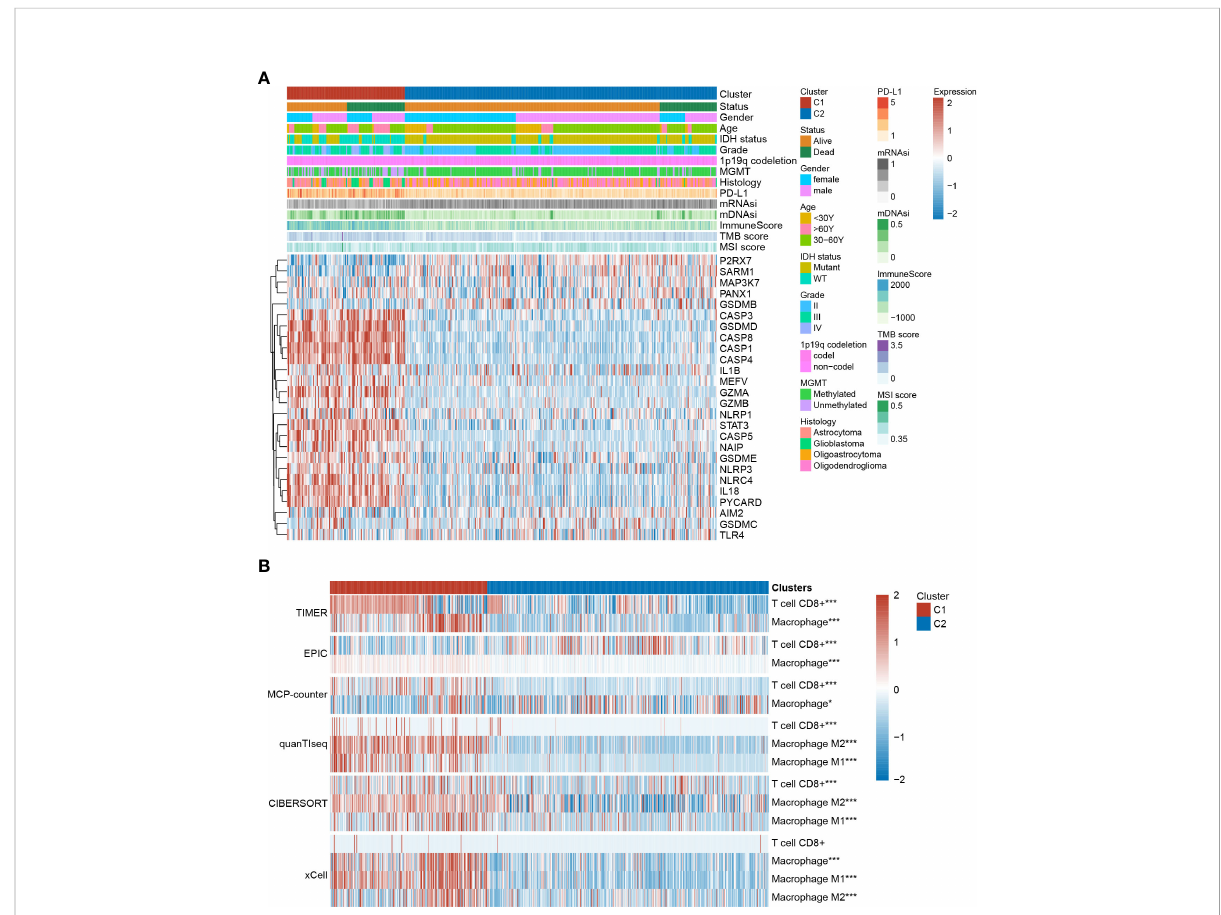
FIGURE 3 The clinical characteristics and immune in fi ltration status differ between Cluster 1 and Cluster 2. (A) Clinical and molecular characteristics of Cluster 1 and Cluster 2. (B) Immune in fi ltration analysis based on TIMER, EPIC, MCP-counter, quanTIseq, CIBERSORT, and xCell algorithms. *P < 0.05; **P < 0.005; ***P <